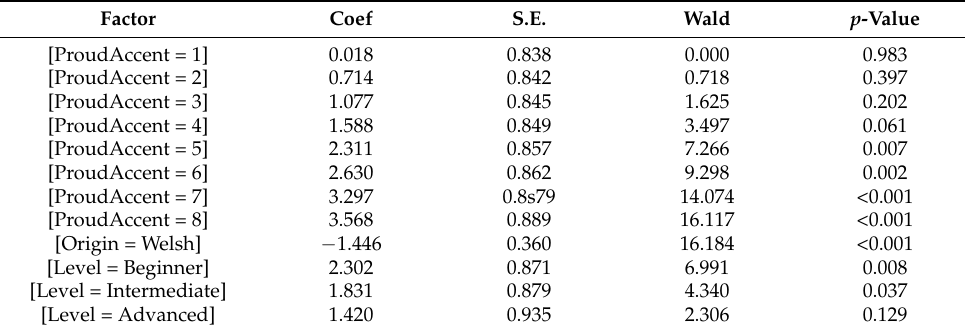
Table A6. Coefficients for I want to change my accent in